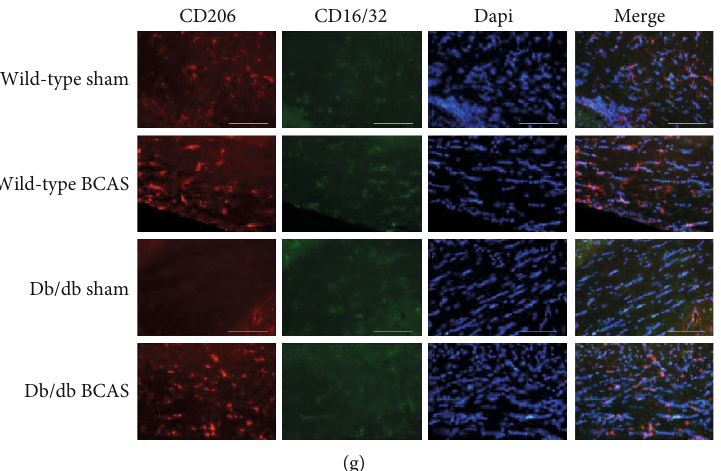
Figure 6: Expression of in fl ammatory cytokines in the corpus callosum of wild-type and db/db mice with sham or BCAS operation for four weeks. Relative mRNA expression levels of proin fl ammatory cytokines TNF- α (a), IL-1 β (b), and IL-6 (c), and anti-in fl ammatory cytokines IL-4 (d), IL1Ra (e), and IL-10 (f) against GAPDH were examined by real-time PCR. M1/M2 microglial phenotypes in the mice corpus callosum were examined by immuno fl uorescence staining. Anti-CD16/32 antibodies were used to label M1-positive microglia, and anti- CD206 antibodies were used to label M2-positive microglia (g). In (a – d), comparisons between di ff erent time points were analyzed using Fisher ’ s LSD test; in (e), comparison between di ff erent time points was analyzed using Dunnett ’ s test; in (f), comparison between di ff erent time points in the wild-type group was analyzed using Kruskal Wallis test, and comparison between di ff erent time points in db/db group was analyzed using Fisher ’ s LSD test. N = 3 − 5 , scalebar = 100 μ m , ∗ p < 0 : 05 , and ∗∗ p < 0 : 01 . Wild-type: wild-type mice, Db/db: db/db